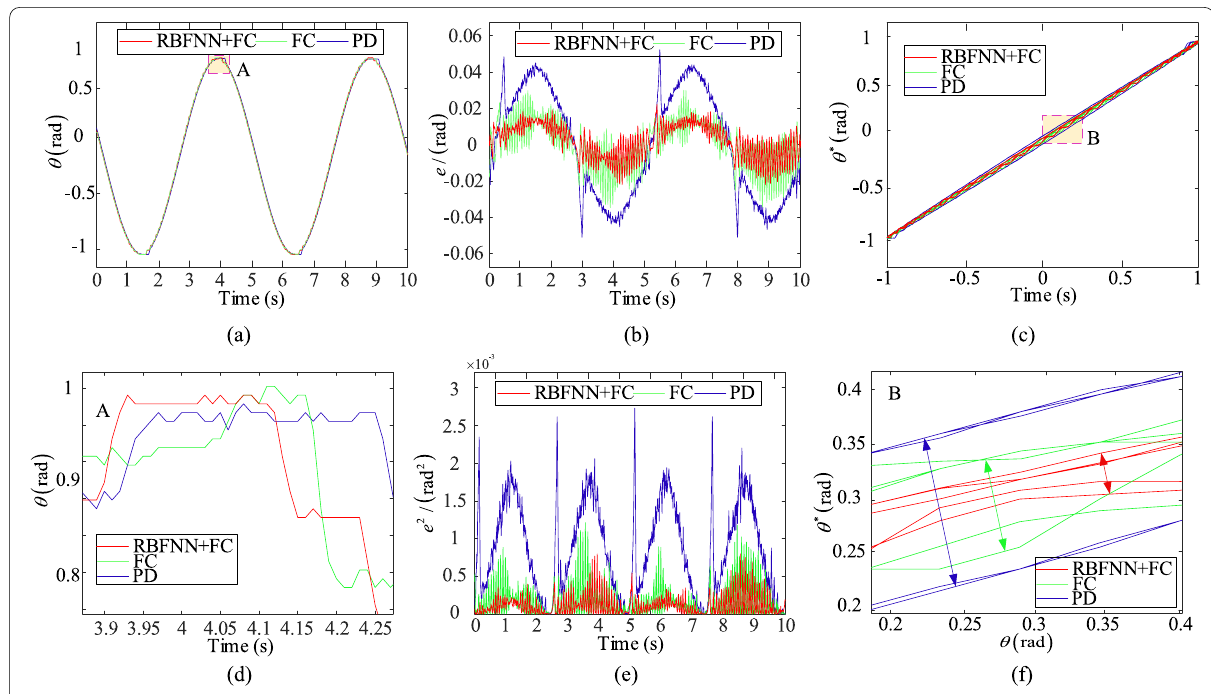
Figure 14 Output results under different control strategies when the length of the flexible manipulator is 1 m: ( a ) Rotation angle curve, ( b ) Error curve, ( c ) Relationship between input and output, ( d ) Partial enlarged view of ( a ), ( e ) Error quadratic curve, ( f ) Partial enlarged view of ( c )